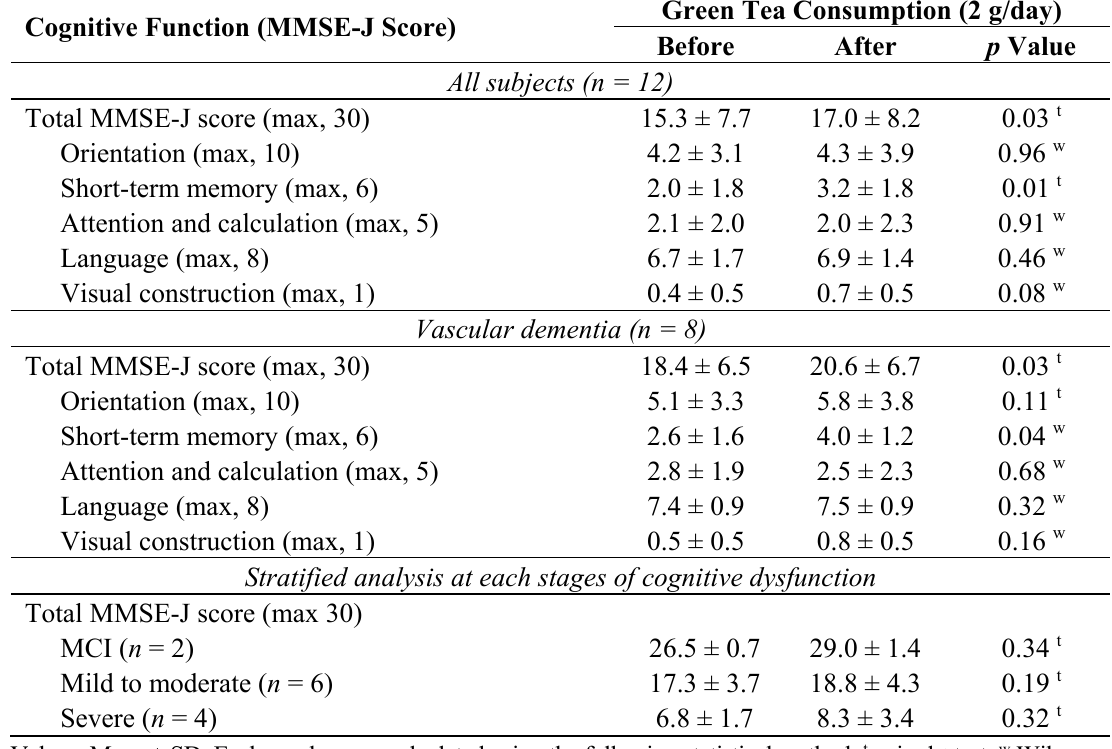
Table 2. MMSE-J scores before and after 3 months of green tea